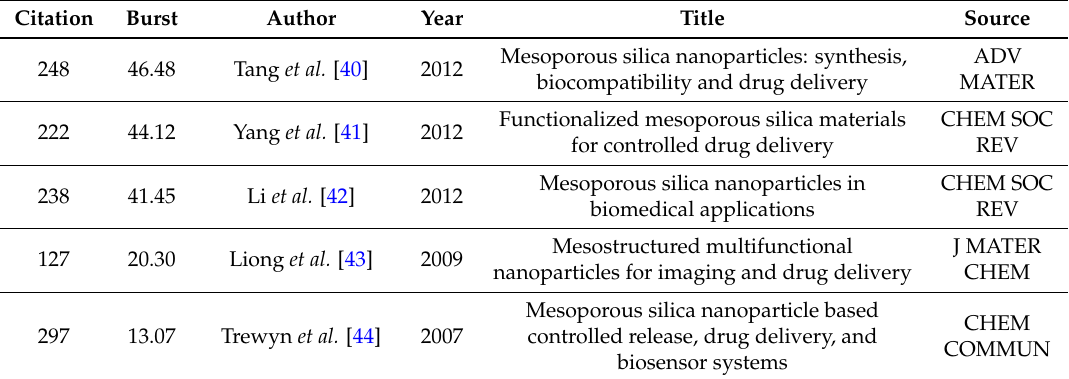
Table 3. Articles with the strongest citation bursts in cluster #3.